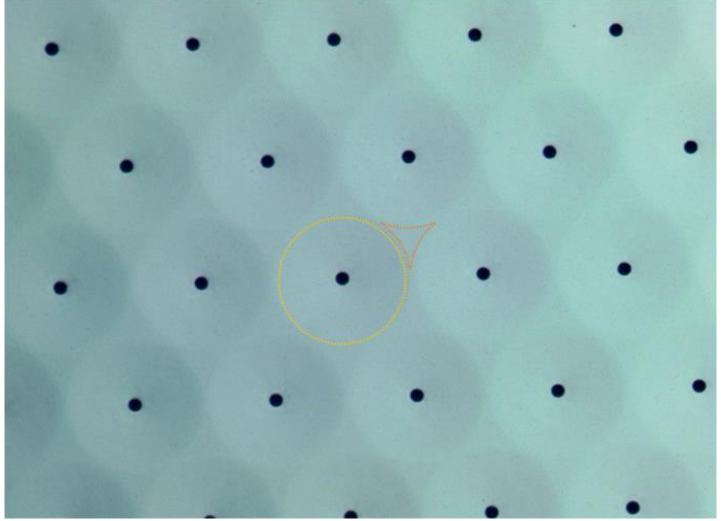
Figure 6. Optical image of a mirror matrix (sample 1) with grazing illumination to highlight the mirror effective area (yellow) and the oxide supports areas (orange).